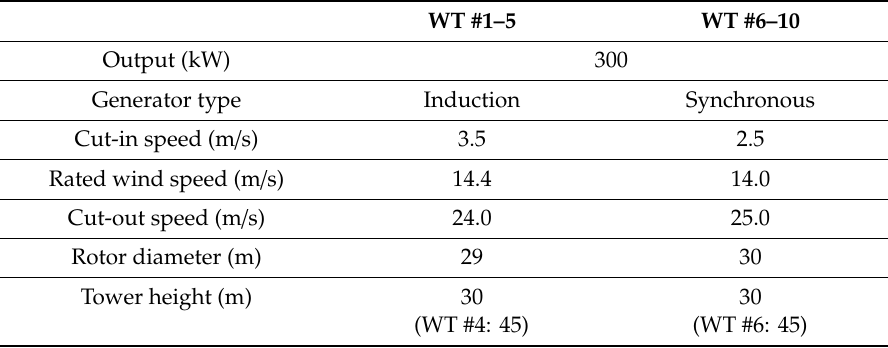
Table 1. Specifications of wind turbines (WTs) at Noma Wind Park.